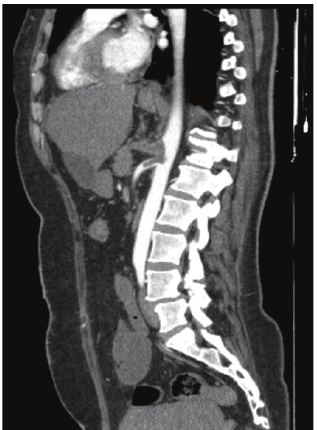
Figure 2: Sagittal image of solid organs with hypodense areas.